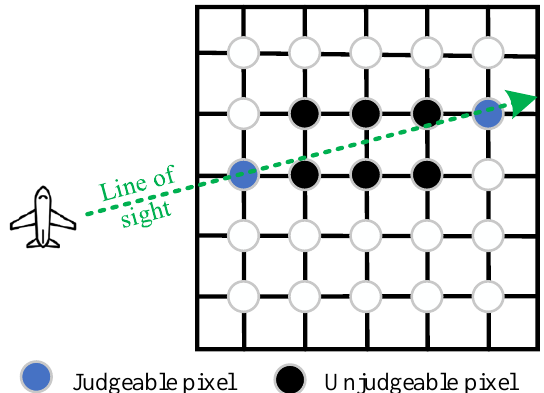
Figure 5. Schematic of the influence of the pixel division on occlusion judgment.